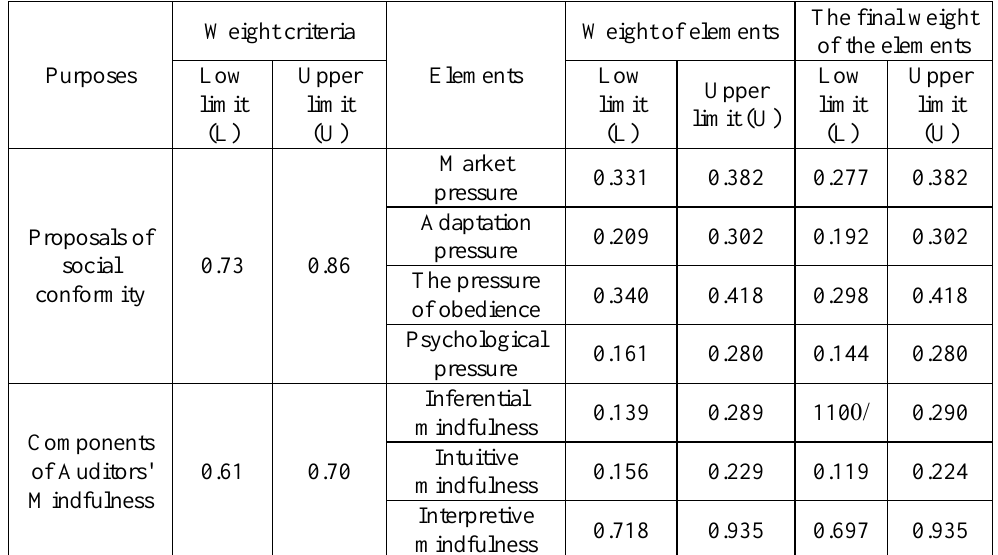
Table 8. Results of the Gray Hierarchical Analysis Process